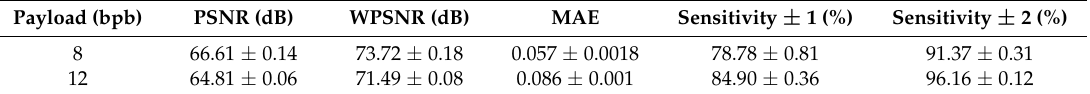
Table 1. The performance of the proposed algorithm on a set of RGBA images publicly available. Payload